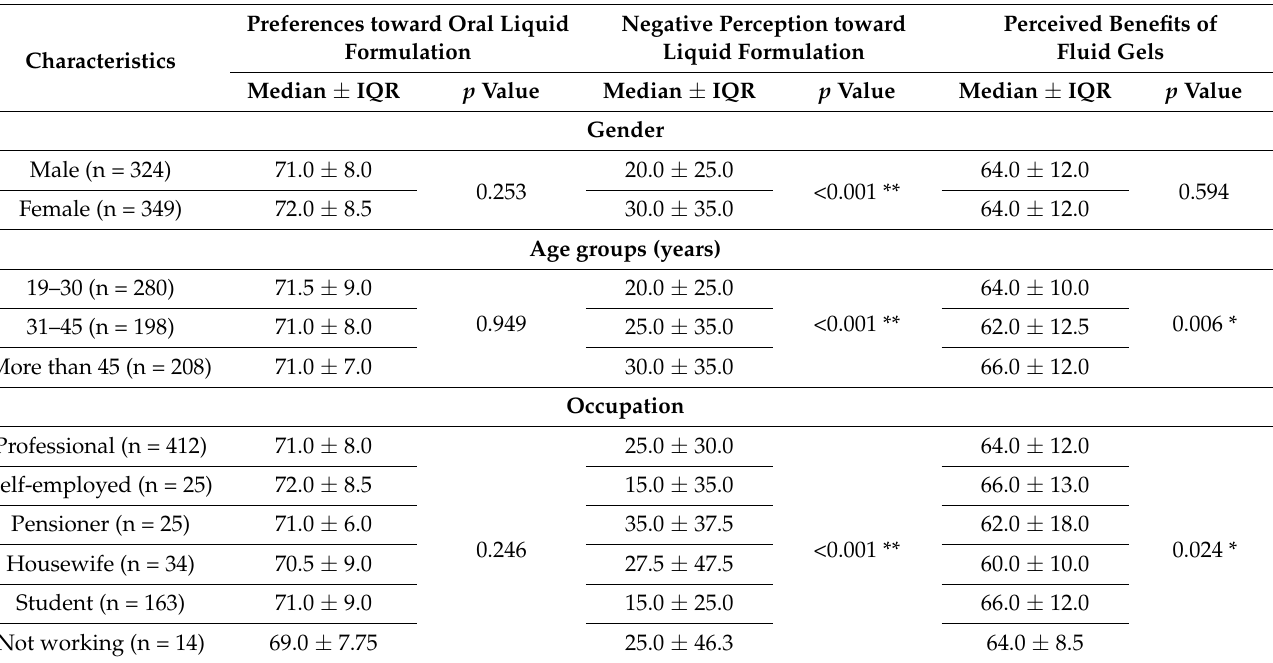
Figure 1. Preferences of oral liquid formulations for medicines, Section 2 (n = 673). Table 2. Mean scores of preferences toward liquid formulations, negative perception toward liquid formulations, and perceived benefits of fluid gels, based on demographic data (n =